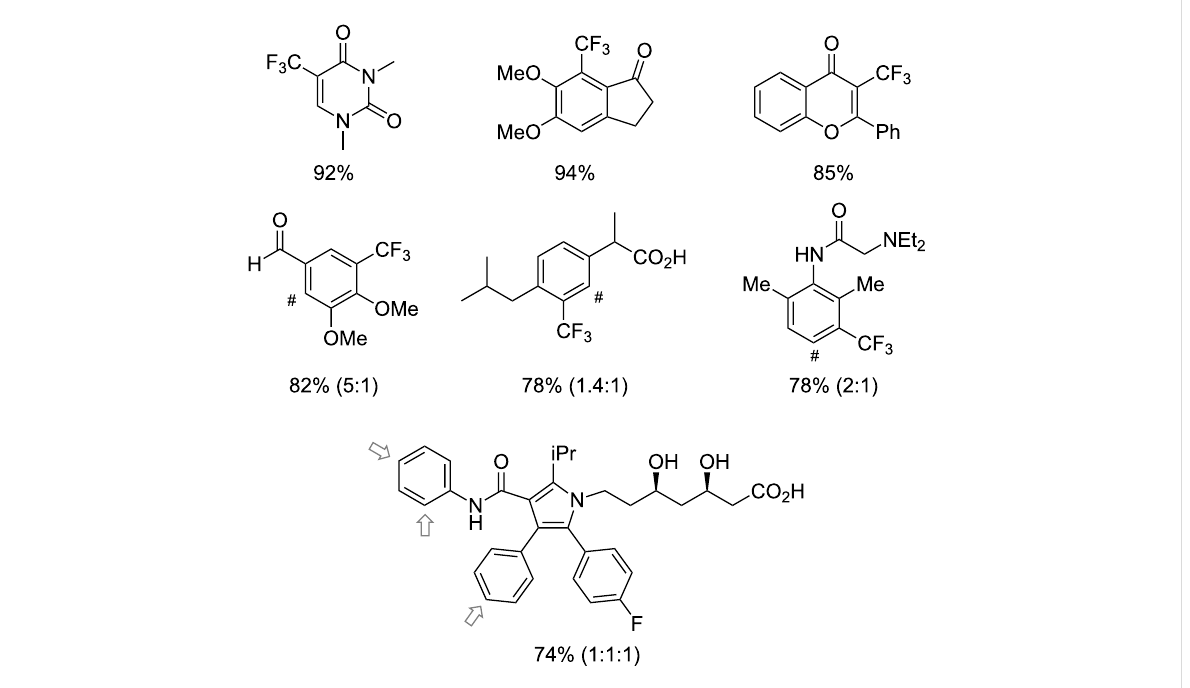
Figure 16: Late-stage trifluoromethylation of pharmaceutically relevant molecules with trifluoromethanesulfonyl chloride by photoredox Ru-catalysis (D. W. C. MacMillan et al.) (The position of the CF 3 group in the other isomers produced is marked with # or an arrow) [105].